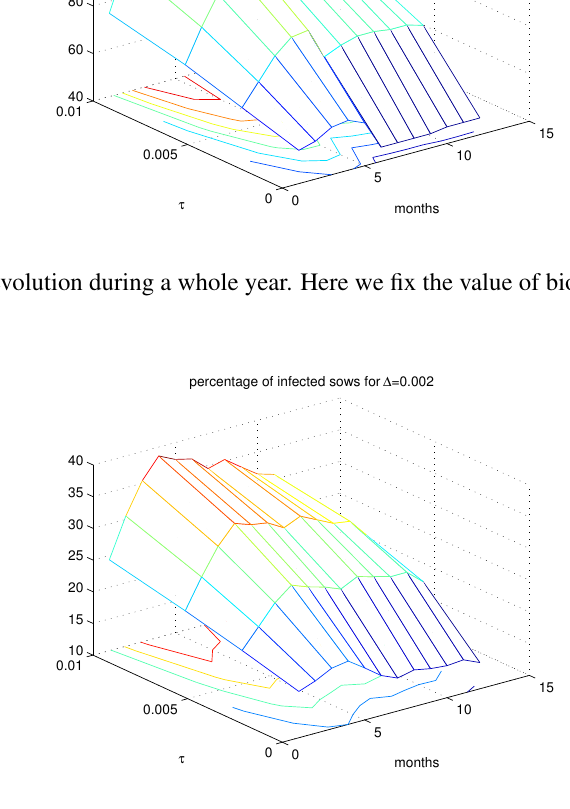
Fig. 9 Percentage of infected sows evolution during a whole year. Here we fix the value of biohazard rate at ∆ = 0 .